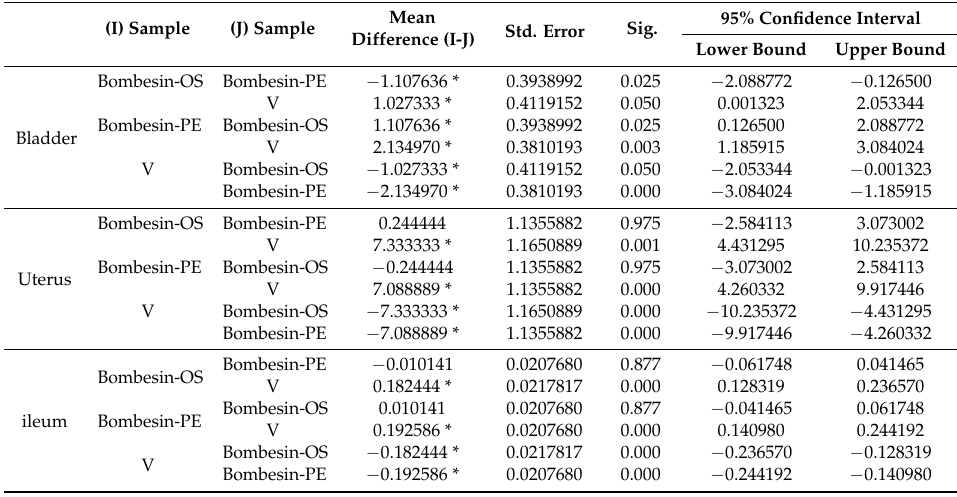
Table 1. Multiple comparisons of contractile activity of peptides (1 µ M) on isolated tissues. The error term is Mean Square (Error) = 0.002. *. The mean difference is significant at the 0.05